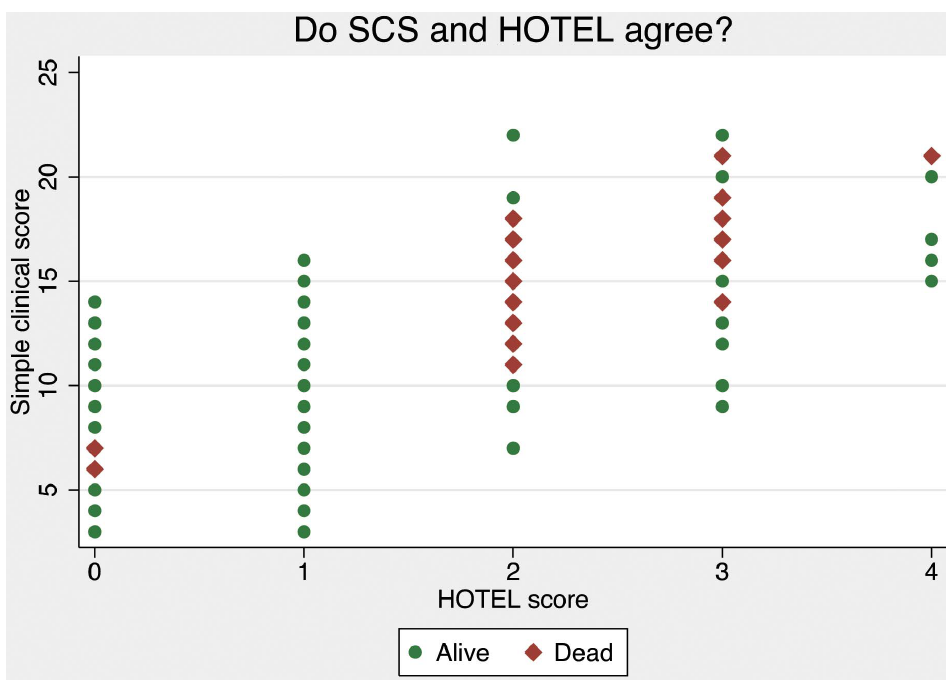
Figure 3. Scatter plot of SCS vs. HOTEL scores.